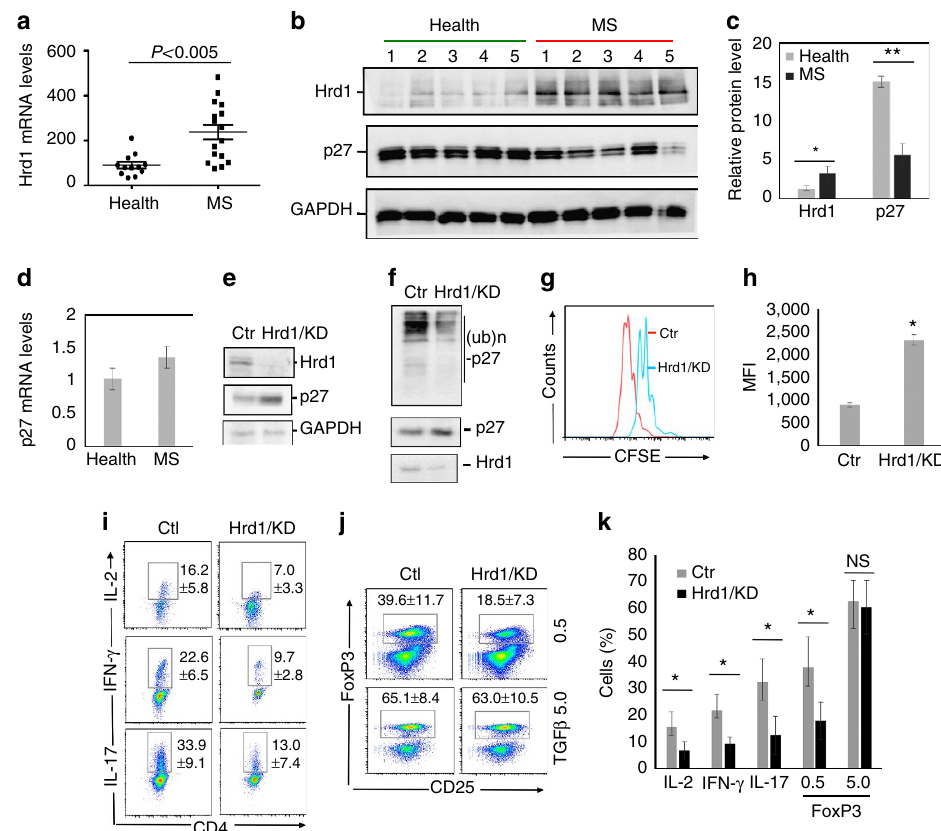
Figure 7 | Analysis of Hrd1 expression and functions in human CD4 Tcells. ( a ) The levels of Hrd1 expression in freshly isolated CD4 Tcells from healthy donors ( N ¼ 12) or MS patients ( N ¼ 16) by real-time PCR. ( b – d ) CD4 Tcells freshly isolated CD4 Tcells from healthy donors or MS patients ( N ¼ 5) were lysed and subjected to western blotting analysis for the protein levels of Hrd1 and p27 kip1 using GAPDH as a loading control ( b ), and the relative band intensities were quantified ( c ). The mRNA levels of p27 kip1 in samples of ( b ) were determined by real-time PCR using b -actin as a control ( d ). ( e – k ) Purified CD4 T cells from healthy donors were infected with lentivirus carrying control or Hrd1-specific shRNA. ( e , f ), green fluorescent protein (GFP)-positive cells were sorted, the expression levels of Hrd1, p27 kip1 and GAPDH were examined by western blotting ( e ), and p27 kip1 ubiquitination was determined as in Fig. 4a ( f ). ( g , h ) Cells were stained with far-red cell trace and cultivated for 3 days with TCR/CD28 stimulation. GFP-positive cells were gated and the proliferation was analysed for CFSE dilution. ( h , i ) Cells were cultivated under Th1, Th17 and Treg polarization conditions and the gated GFP þ cells were analysed. Representative images ( g , i , j ) and the percentages from three independent experiments ( h , k ) are shown. Mann–Whitney test was used for the statistical analysis in a , c , d , h and k